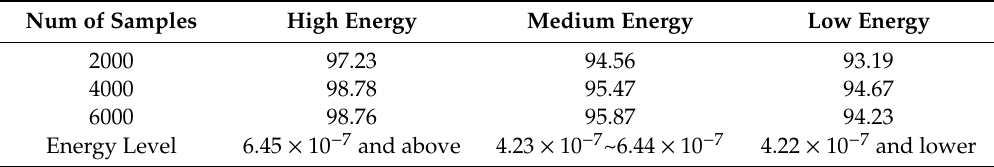
Table 3. Accuracy of energy classification of HI’s.